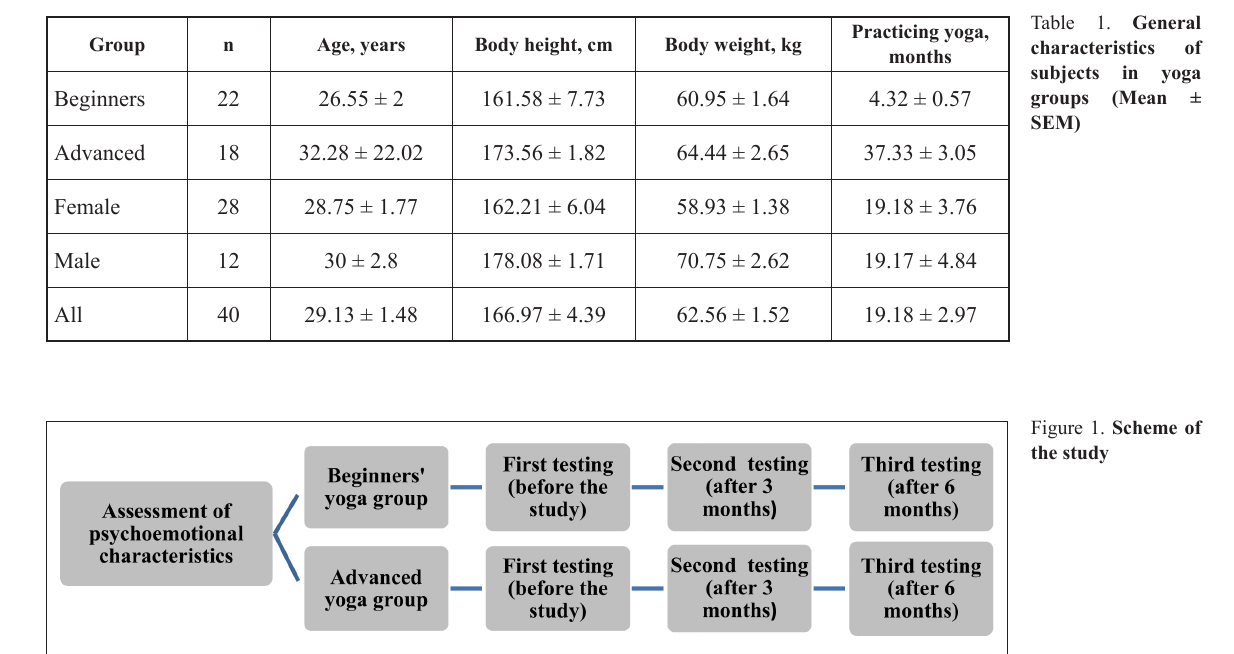
Table 1. General characteristics